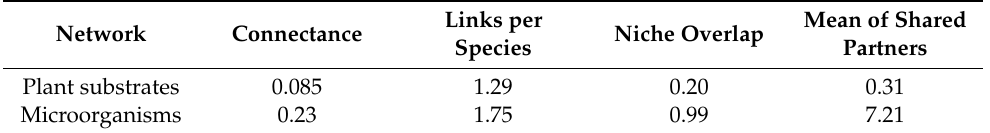
Table 2. Network values for plant substrates and